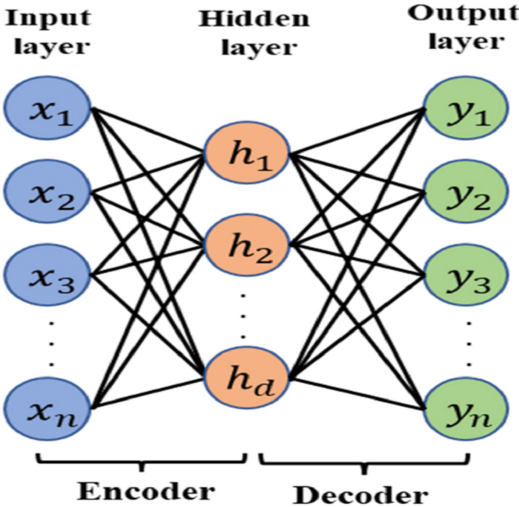
Figure 5. Auto encoder module for convolution neural network [32].